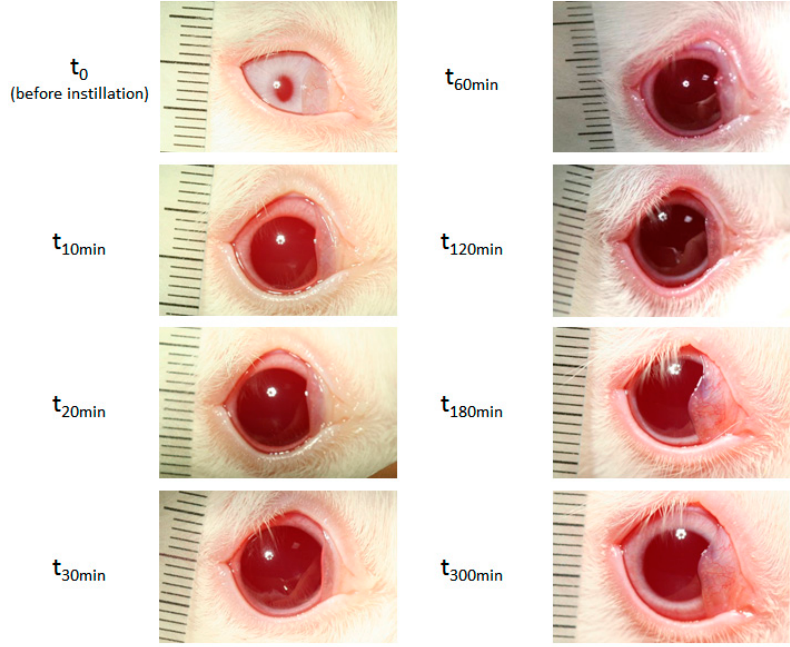
Figure 7. Pictures recorded 5 hours following the administration of in situ gelling delivery system (Formulation A).